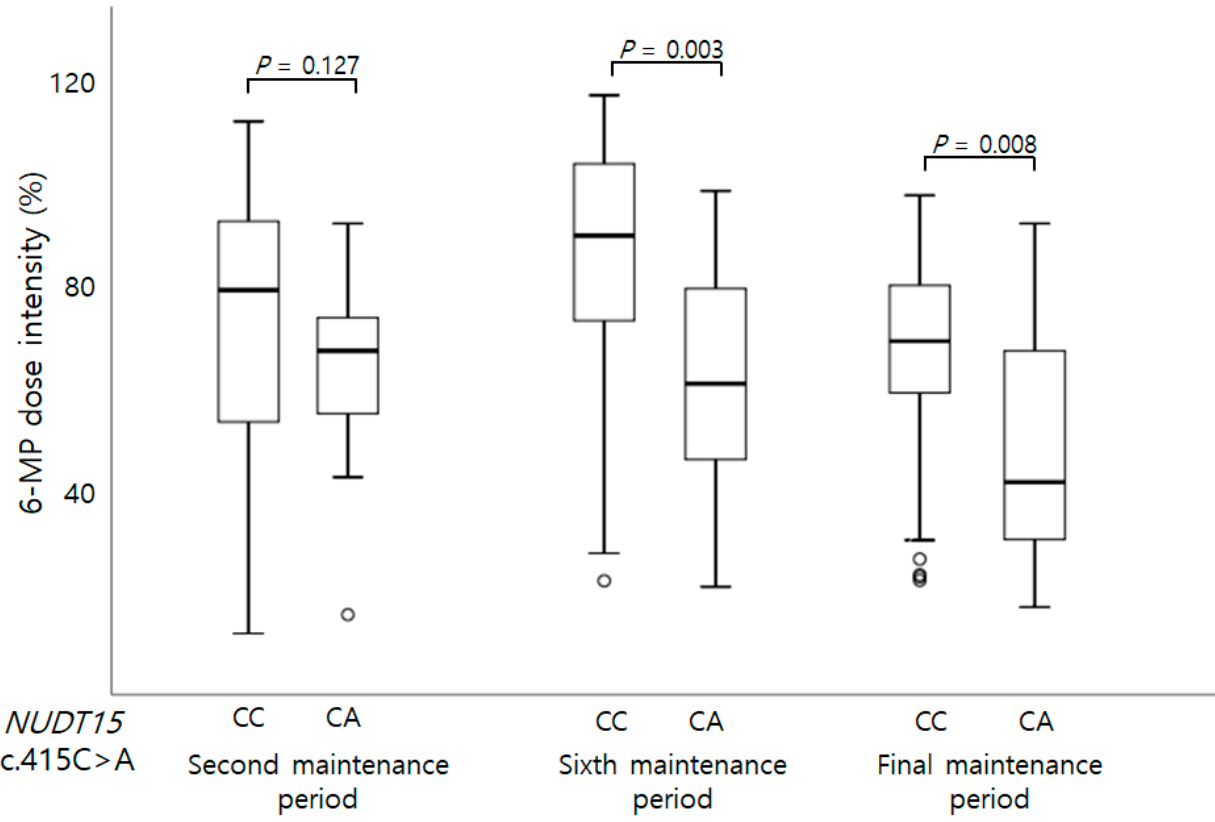
Figure 1. Genotype of NUDT15 c.415C>A and adjusted 6-MP dose at second, sixth, and final maintenance periods. The adjusted 6-MP dose at final maintenance period was significantly low in patients carrying CA heterozygote than those with wild CC genotype.